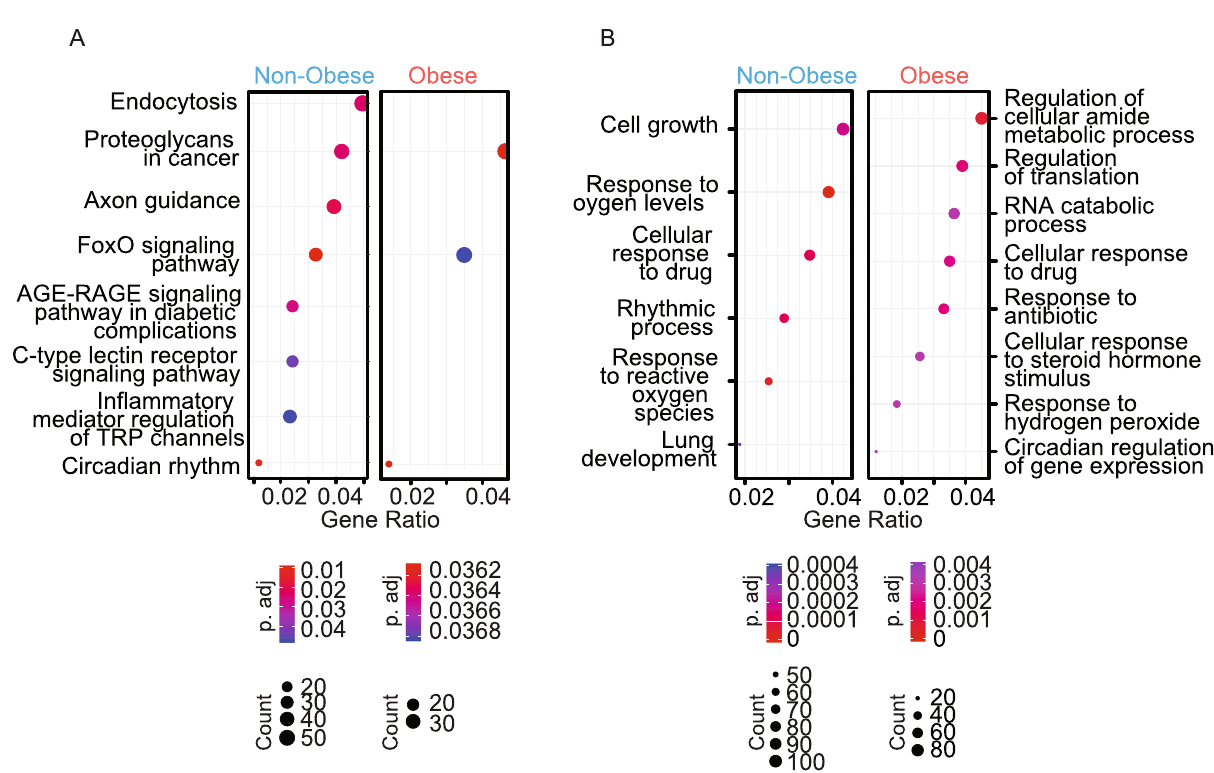
Fig. 8 Targets bound by endogenous BMAL1 in human omental adipocyte precursors: functional pathways and biological processes revealed by ChIP- seq analysis. A Functional pathway analysis of the sites bound by BMAL1 in OAPs from obese and non-obese patients. Genes that were within 10,000 bases of the center of each peak were selected for downstream analysis. Functional gene pathway analysis was performed using the KEGG pathway database. The dot plot shows signi fi cantly enriched pathways in each group and statistics for each pathway. “ Count ” indicates the number of genes enriched in a speci fi c pathway and “ Gene ratio ” the percentage of genes differentially bound in the given pathway. B Gene ontology (GO) analysis ( “ biological process ” sub-ontology) revealed that bound targets of BMAL1 in either non-obese or obese OAPs are enriched for genes involved in canonical circadian functions, but are also enriched for many other genes involved in different functions. A , B p- value was determined using a hypergeometric statistical test and adjusted with the Benjamini – Hochberg procedure. See also Supplementary Fig.